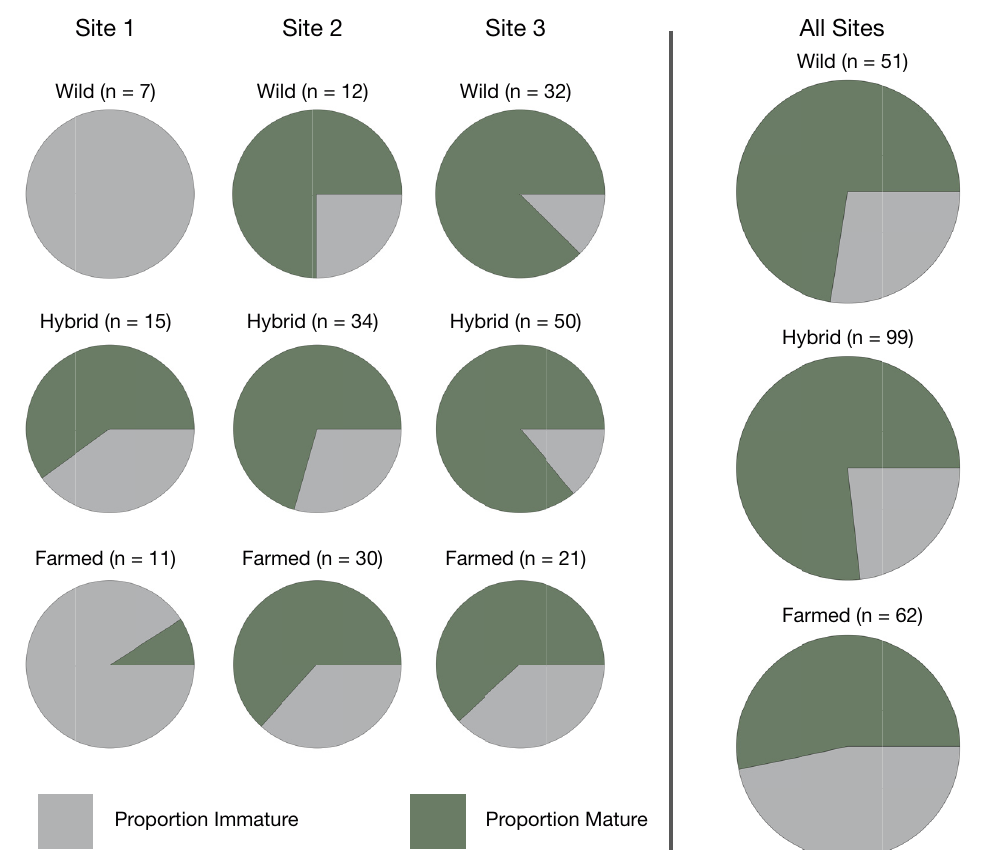
Fig. 5. Proportions of immature and mature male Atlantic salmon parr from 3 genetic class cross types (pure wild, F1 hybrid, and pure farmed) experimentally placed in the Garnish River in southern Newfoundland. Lab-created crosses were made in late 2017 and released at 3 sites within the Garnish River in July 2018 and resampled in September